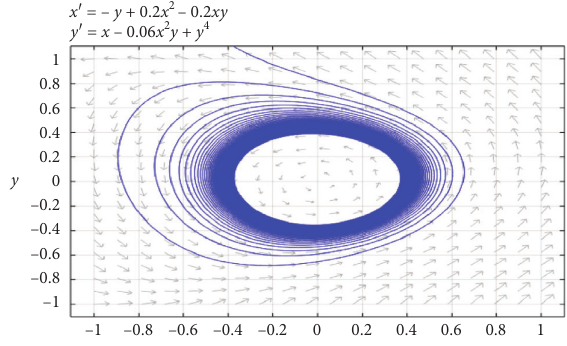
Figure 2: Nonexistence of limit cycle for system (6).